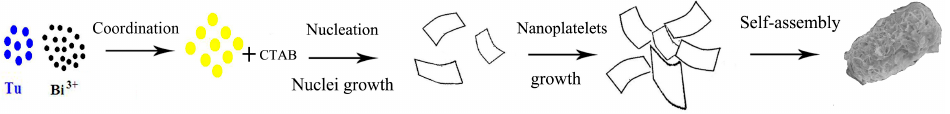
Figure 4. Schematic illustrating the formation process of 3D hierarchical Bi 2 S 3 architectures.